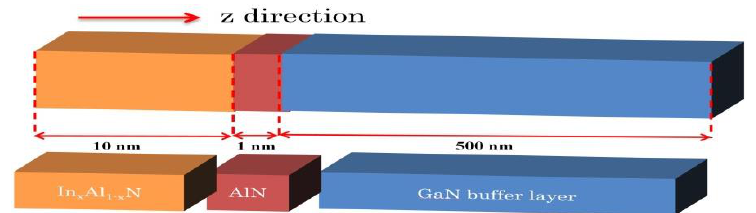
Figure 1. Schematic of the In x Al 1−x N/AlN/GaN heterostructure studied in this work.